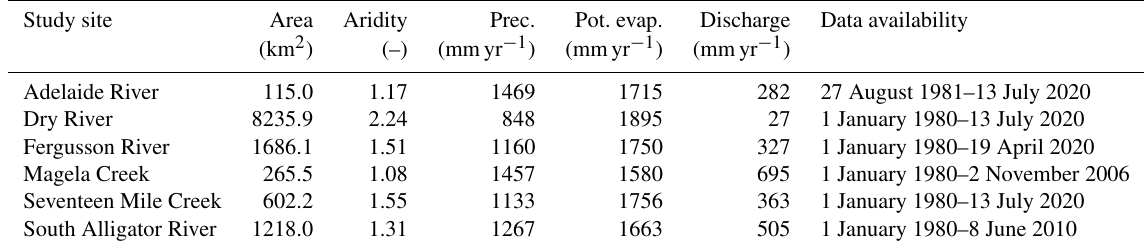
Table 2. Characteristics of the six Australian